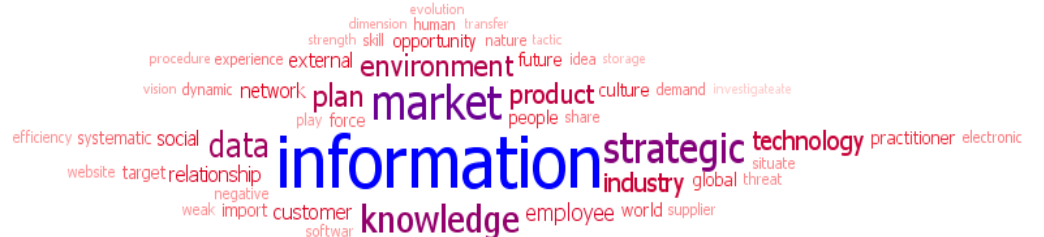
Figure 6. Word cloud of fifth